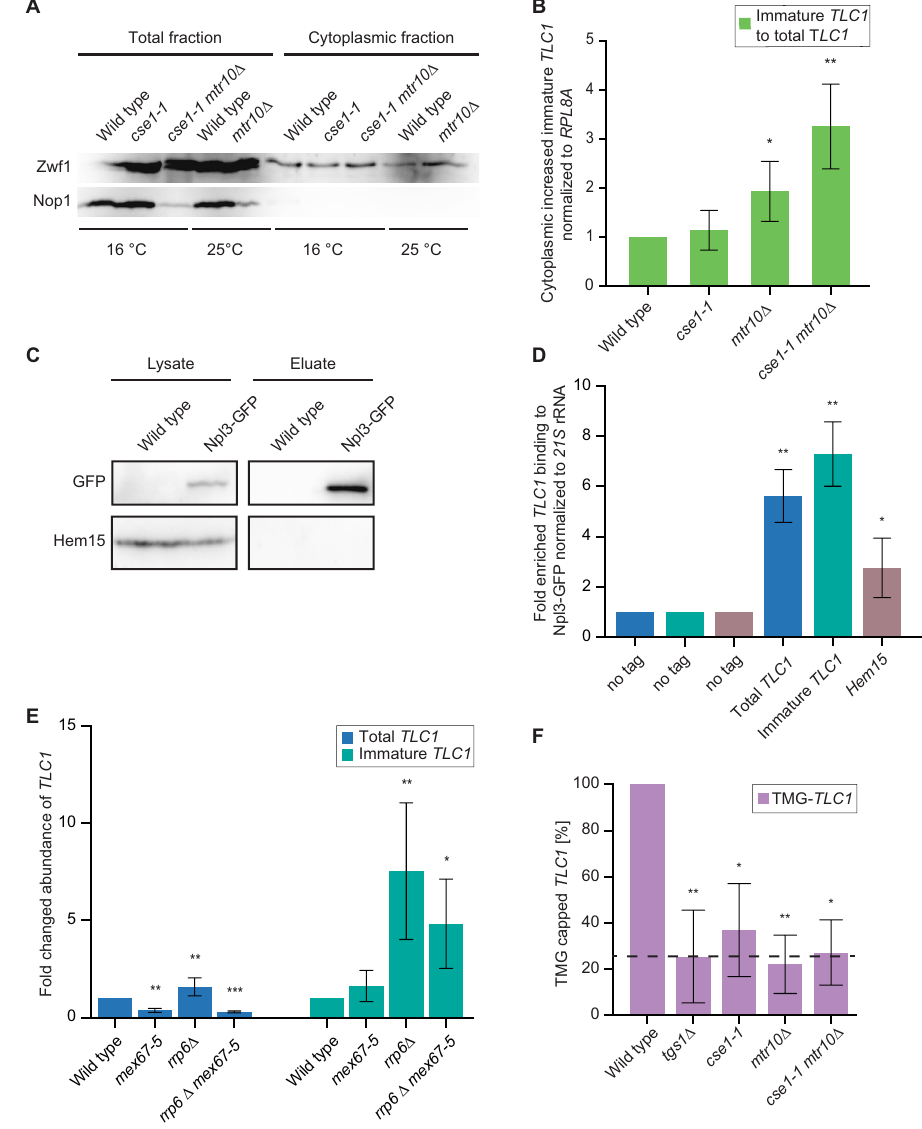
Figure 6. Processing and TMG-capping of TLC1 occurs in the nucleus upon TLC1 re-import. ( A ) Immature TLC1 accumulates in import factor mutants. A Western blot of a nucleo-cytoplasmic fractionation experiment is shown for the indicated strains. The nuclear Nop1 protein and the cytoplasmic Zwf1 protein served as controls for successful isolation of the cytoplasmic fraction. Strains were shifted to 16 °C for 1 h 15 min prior to the experiments. n = 5. Image was cropped from the original. Original image can be found in Supplementary Fig. S6A. ( B ) qPCRs of the fractionation experiments shown in ( A ) reveals an accumulation of the immature TLC1 in the import factor mutants at the permissive termperature. n = 5. ( C ) Western blot showing an example of a Npl3 IP used in ( D ) in the RIP experiments. Image was cropped from the original. Original image can be found in Supplementary Fig. S6B. ( D ) TLC1 binds to Npl3. The Npl3 co-precipitated RNA was used as a template in qPCRs for TLC1 and Hem15 as positive control. n = 4. ( E ) Trimming of TLC1 is mediated by the nuclear exosome after nuclear re-import. The RNA was isolated from the indicated strains after shifting them to 37 °C for 2 h. Subsequently, qPCRs were carried out that determined the amount of the total TLC1 and its immature, longer precursor. Mex67-5 and rrp6∆ mex67-5 n = 4. Rrp6∆ n = 8. ( F ) TMG-capping occurs after nuclear TLC1 re-import. The amount of TMG-capped TLC1 was determined by TMG-co-IPs and subsequent qPCRs from the indicated strains. tgs1∆ served as a positive control and the black line indicates the amount of the precipitated non-TMG-capped RNAs resembling the base line for TMG-capping. Tgs1∆ and mtr10∆ n = 4. Cse1-1 and cse1-1 mtr10∆ n =